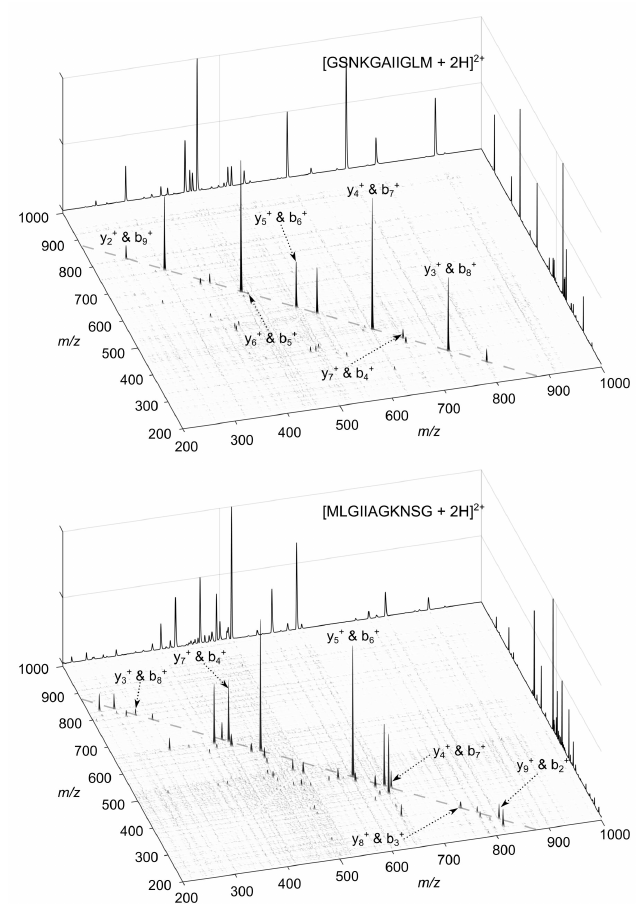
Figure 1. Three-dimensional view of the 2D-PC-MS maps of [GSNKGAIIGLM+2H] 2+ ( I1 2+ , top ) and [MLGIIAGKNSG+2H] 2+ ( I2 2+ , bottom ). The standard 1D tandem mass spectra are appended to the x- and y-axes for visual clarity. The single primary mass conservation line, characteristic of doubly charged peptides (see Equation (4)), is shown by the dashed line. Fragment-fragment correlations between the complementary b- and y-fragments lying on the primary mass conservation line are